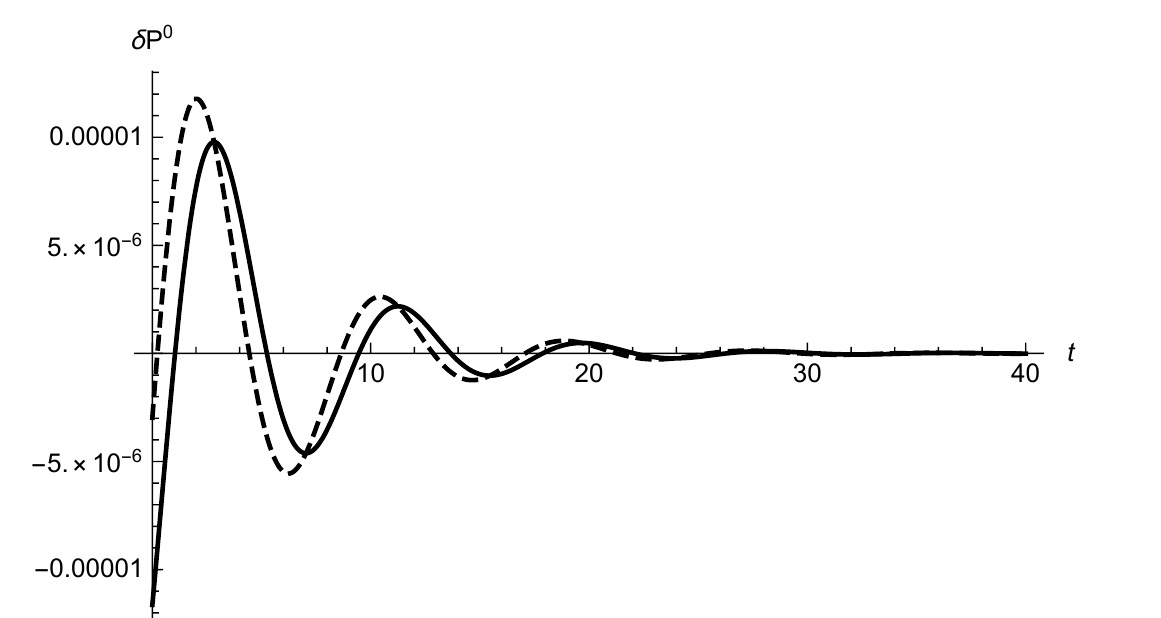
Figure 4. Comparison between the real parts of the gravitational energy of the polar perturbation. The continuous line represents the numerical value of the evaluation, and the dashed line corresponds to the value resulting of the approximate analytic expression (75). The parameters used in the analysis are A = 10 − 6 , m = 1, and the frequency considered is the fundamental one ( n = 0, l = 2) ω = 0.373162 − i 0.089217, obtained by means of the third-order WKB method. The integration is made on a surface of radius r = 60, in natural